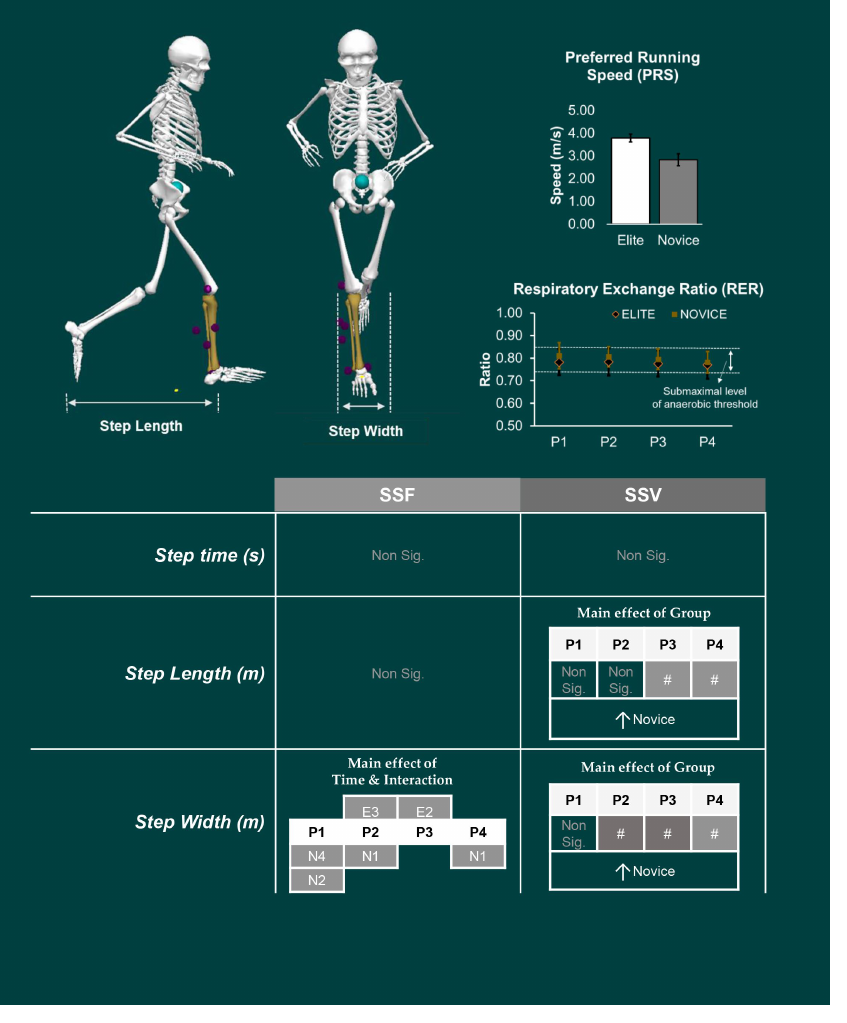
Figure 1. The change in spatiotemporal variables between novice and elite runners throughout the prolonged run is presented here. Note: The main effect of Group and Interaction represented by “#”. The main effect of Time and Interaction for each time interval for each group (E = Elite; N = Novice), for example, the difference in time interval in P1 vs. P2 for novices is denoted as N1 vs. N2. Non-significant differences are represented by “Non sig.”. For details, see Appendix B. The skeleton used for figure was created using Visual3D